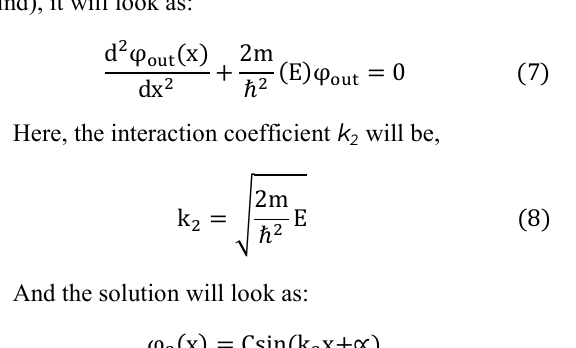
Fig . 3. One-dimensional potential well with finite walls. A